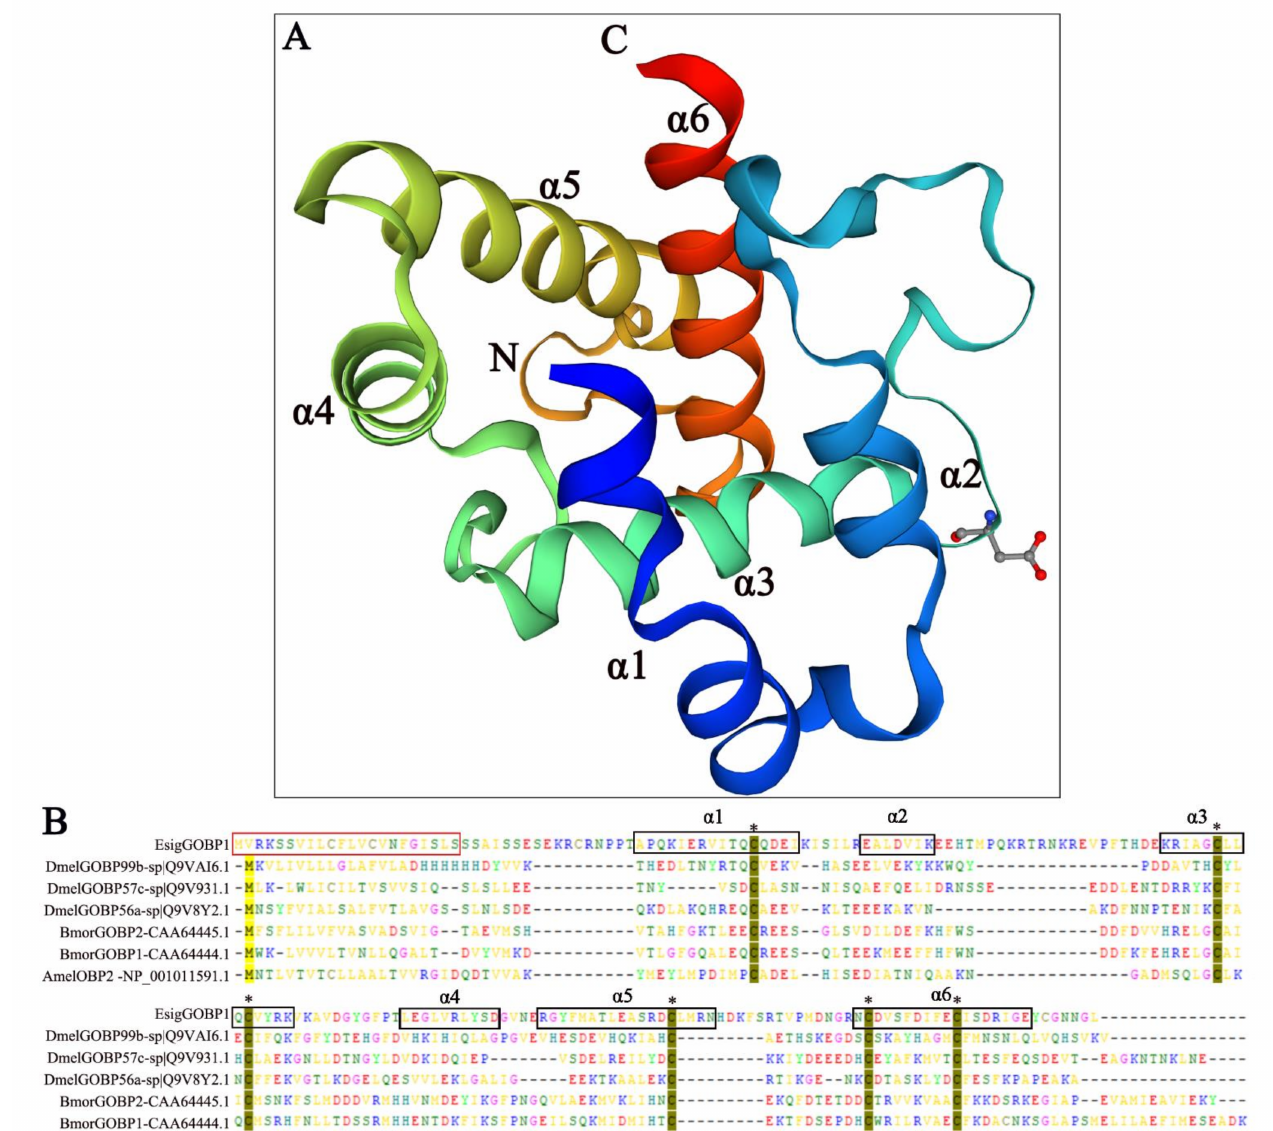
Figure 2. Sequence and structure of EsigGOBP1. ( A ) Three-dimensional structure of EsigGOBP1; ( B ) Alignment of EsigGOBP1 with 3D structures of GOBPs in insect and AmelOBP2. The six a-helices with black boxes are as follows, Ala18–Glu23( α 1a), Ile26-Ile33 ( α 1b), Glu40–Lys46 ( α 2), Lys69–Lys82 ( α 3), Leu94–Asp103 ( α 4), Arg108–Asn125 ( α 5), and Asn140–Glu157 ( α 6); the red boxes refer to signal peptide; the * refer to six conserved cysteines. The structure was predicted using the SWISS MODEL online tools (http://swissmodel.expasy.org/, accessed on 27 May 2022) and based on Helicoverpa armigera pheromone-binding protein PBP1 at pH 7.5 (PDB ID: